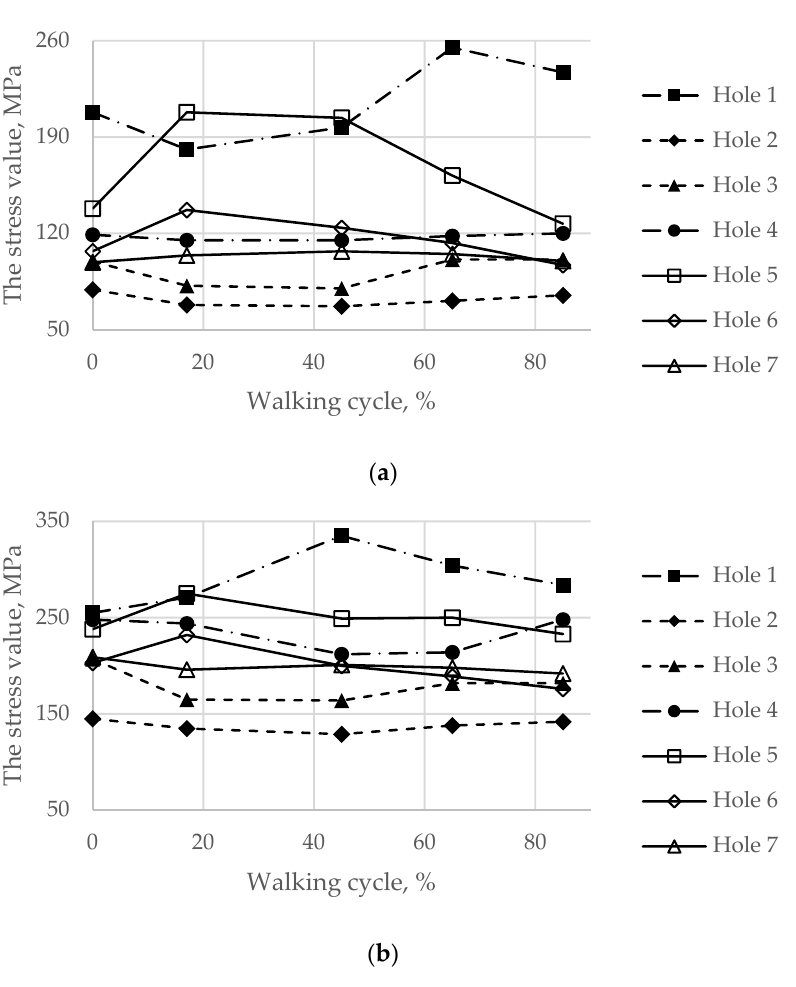
Figure 12. Maximum von Mises stress in the implant on the boundaries of the holes in the walking cycle phases: ( a ) pretension force equal to 500 N; ( b ) pretension force equal to 1000 N.